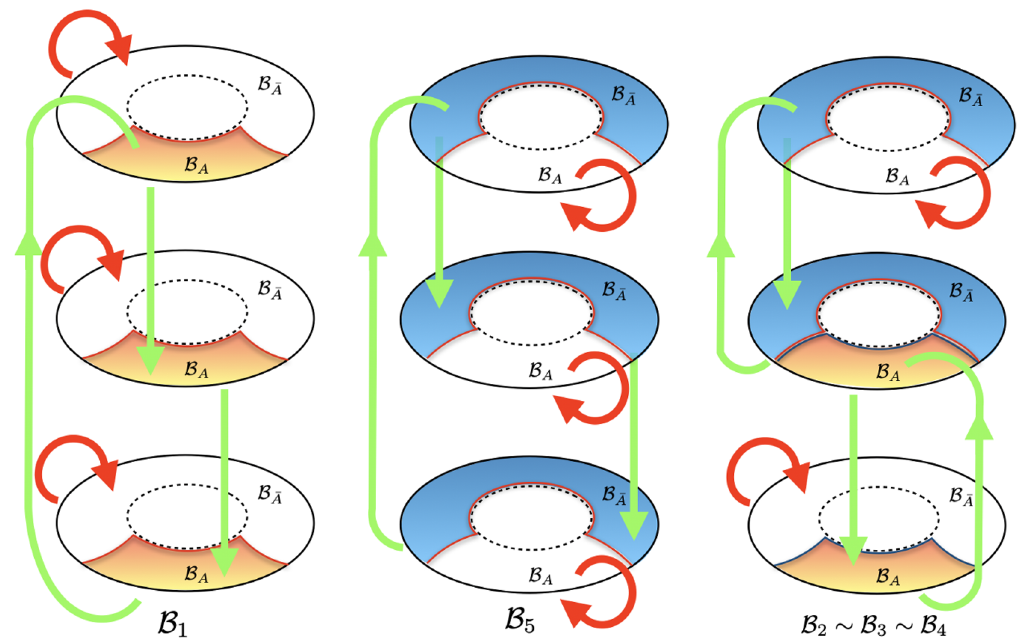
indicate how the three bulk time-slices are glued together for each con(cid:12)guration. The dotted circles represent the